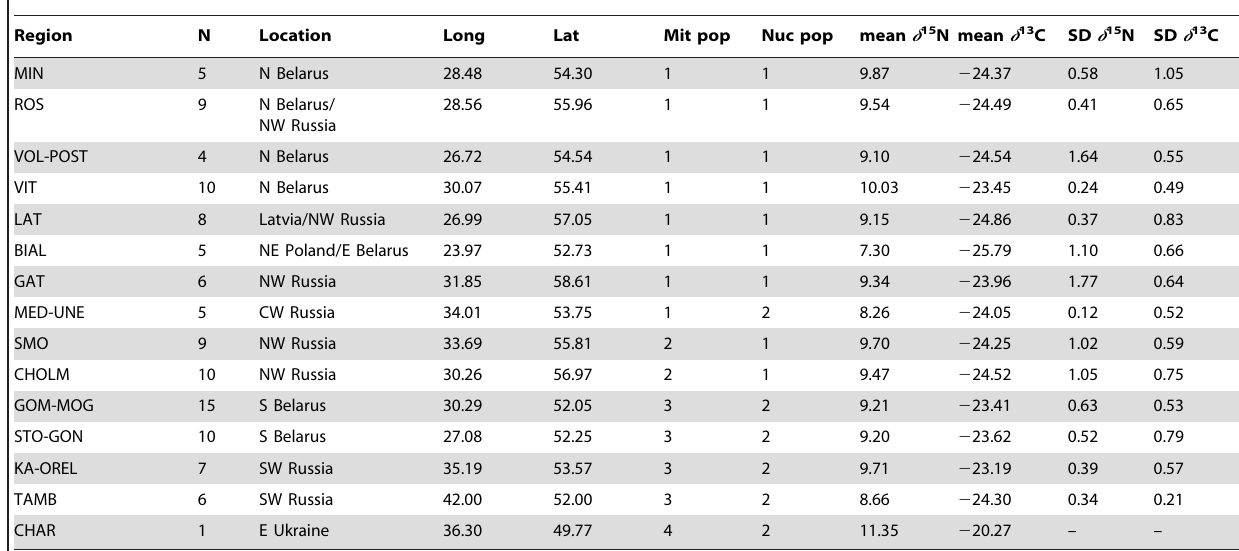
Table 1. Mean and standard deviation of d 15 N and d 13 C values ( % ) for Eastern European wolves from 15 geographical regions.